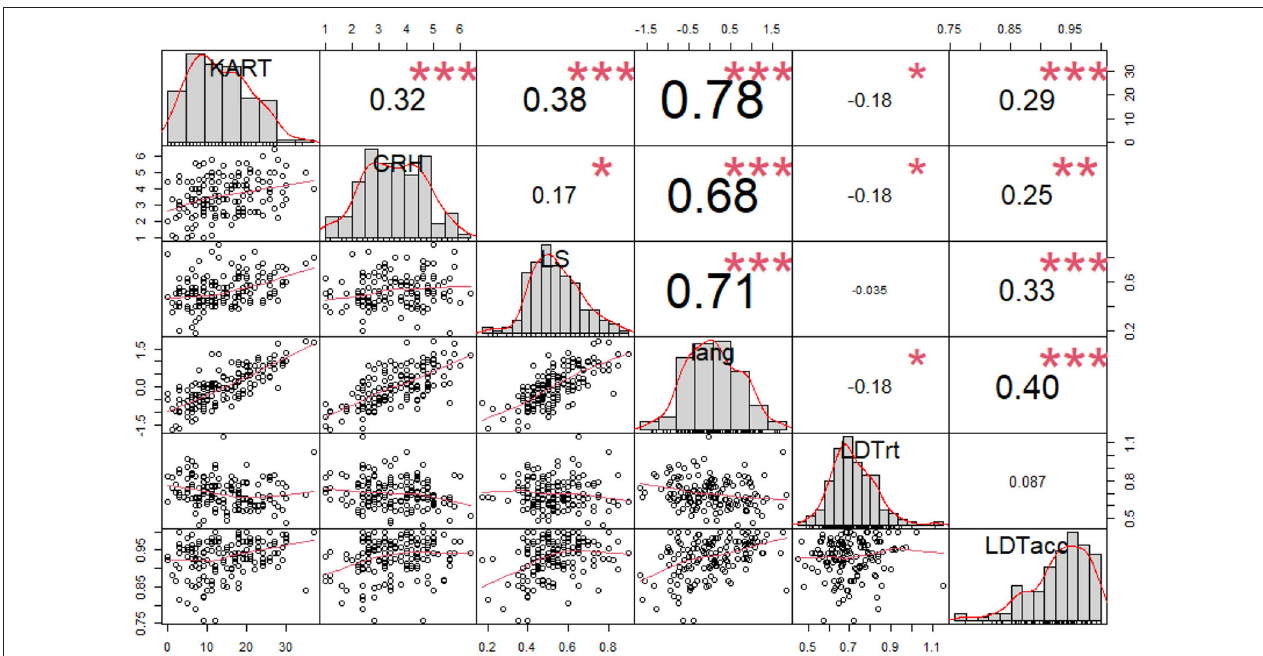
FIGURE 1 | Correlations between KART and other measures. * p < 0.05; ** p < 0.01; *** p < 0.001. The diagonal values are histograms of the distribution of each variable. The upper values of the diagonal are correlation coefficients and the lower values are scatter plots. KART, Korean author recognition test score; CRH, comparative reading habit (average value); LS, language skills test score; lang, composite variable of KART, CRH, LS (average z score of KART, CRH, LS); LDTrt, lexical decision task reaction time; LDTacc, lexical decision task